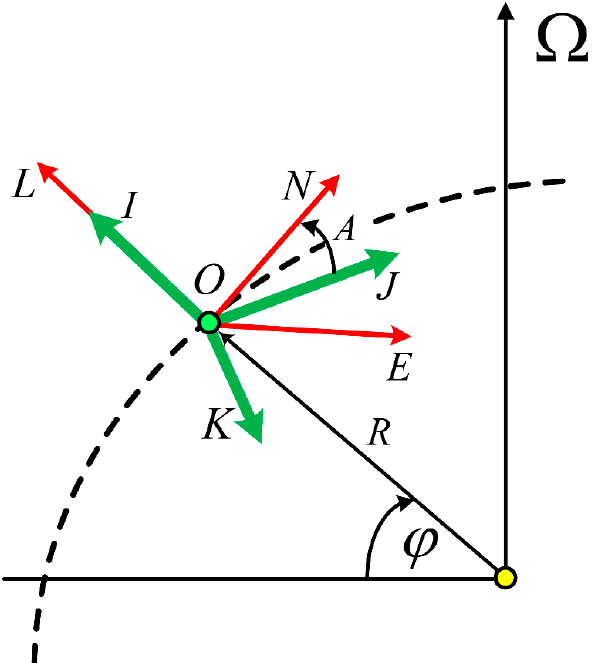
Figure 1. Coordinate Systems (CS) used in study. The OL , ON , and OE axes form a local geographic coordinate system. The OI , OJ , and OK axes form a dush coordinate system. A is the angle of rotation of the axis OJ relative to the plane of the local meridian; R is the radius of the Earth's sphere from its center; φ is a latitude.